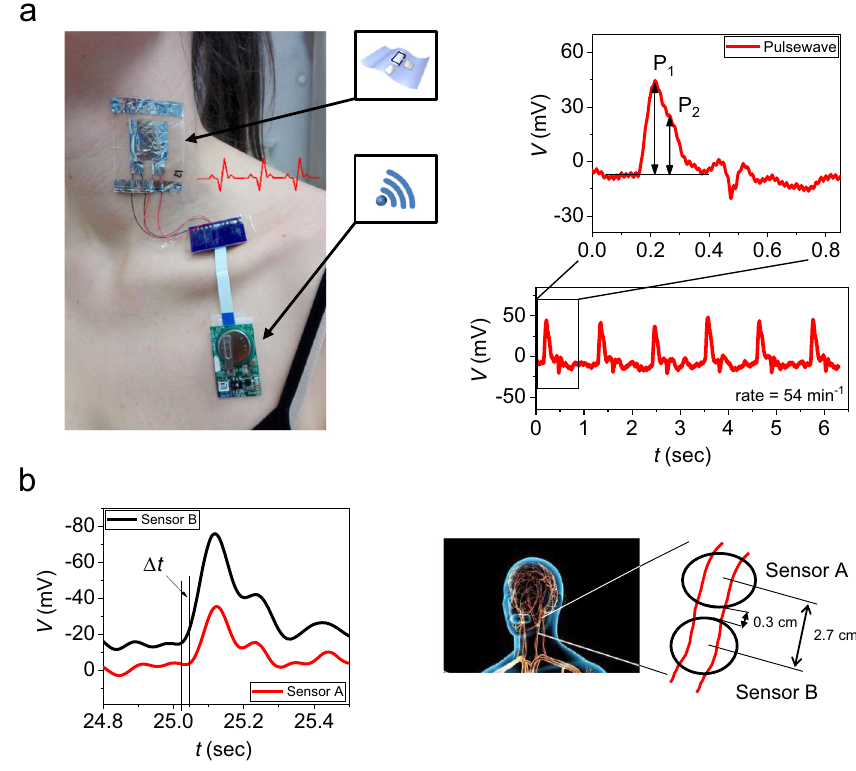
Fig. 5 Wireless e-health patch. Attachment points of the wireless e-health patch, whereby the ultra fl exible transducer serves as an imperceptible sensor that adheres to the skin without adhesive. The patch can monitor ( a ) the human pulse wave (with P 1 and P 2 peaks) from which the rate (here: 54 min − 1 for a 32-year-old woman) and the artery augmentation index AI (here: AI ~56%) can be measured as well as ( b ) the blood pressure of the human arteria in the neck via the pulse wave velocity PWV. PWV can be determined by measuring the signal delay Δ t for a given sensor distance Δ x . In this example, PWV was ~9 m s − 1 for a 34-year-old